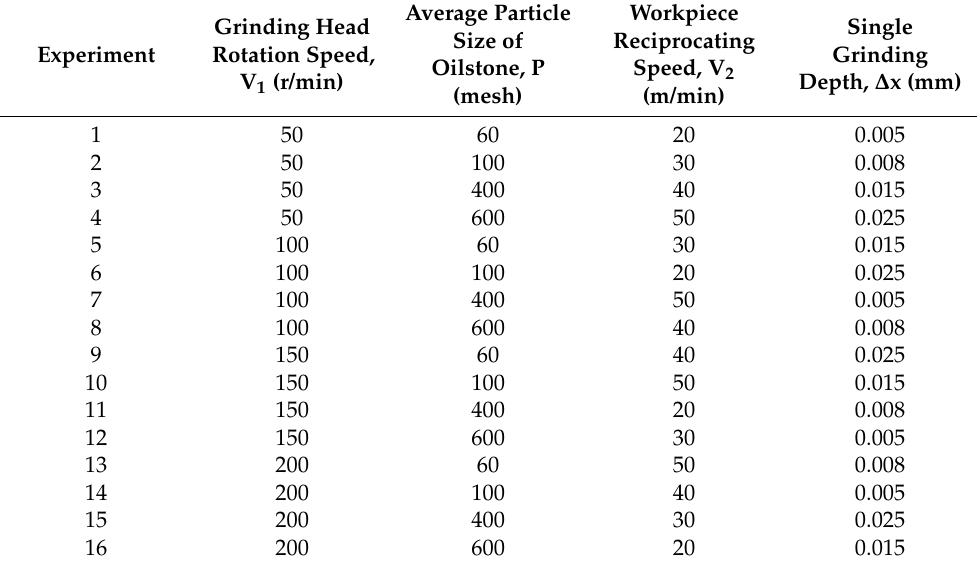
Table 2. Orthogonal experimental design.